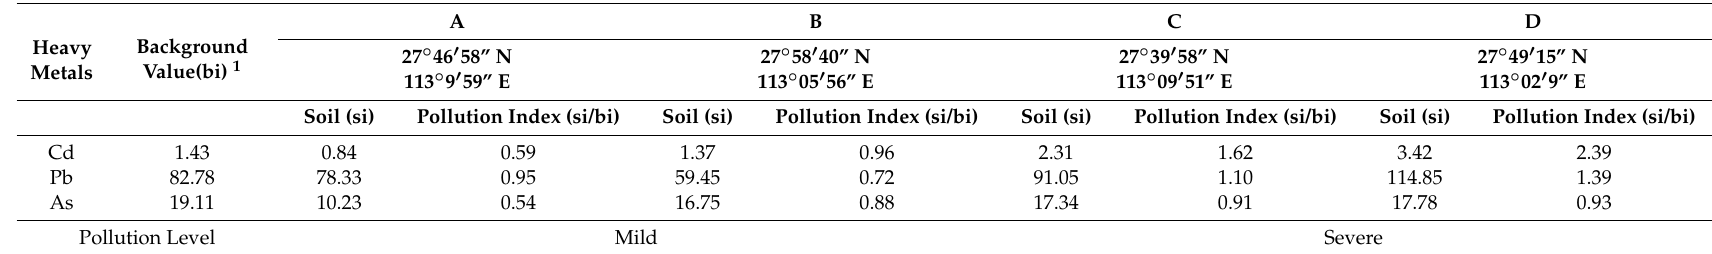
Table 1. The average heavy-metal concentrations in the four experimental areas.